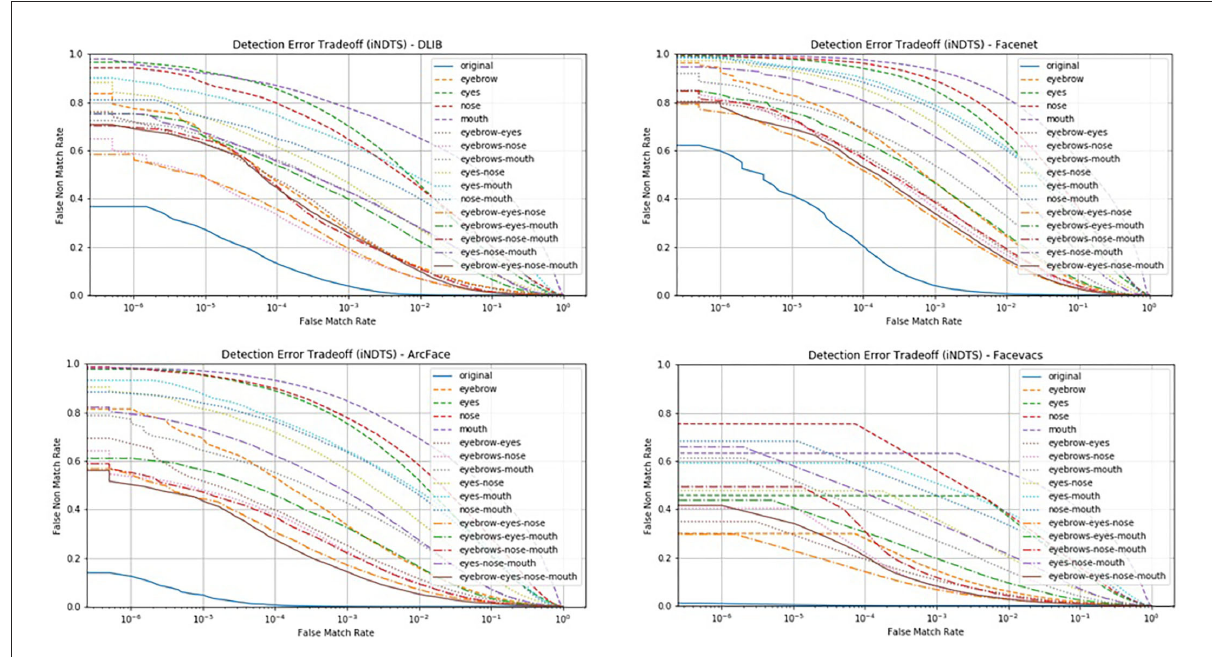
FIGURE11 Face part analysis of iNDTS experiment using